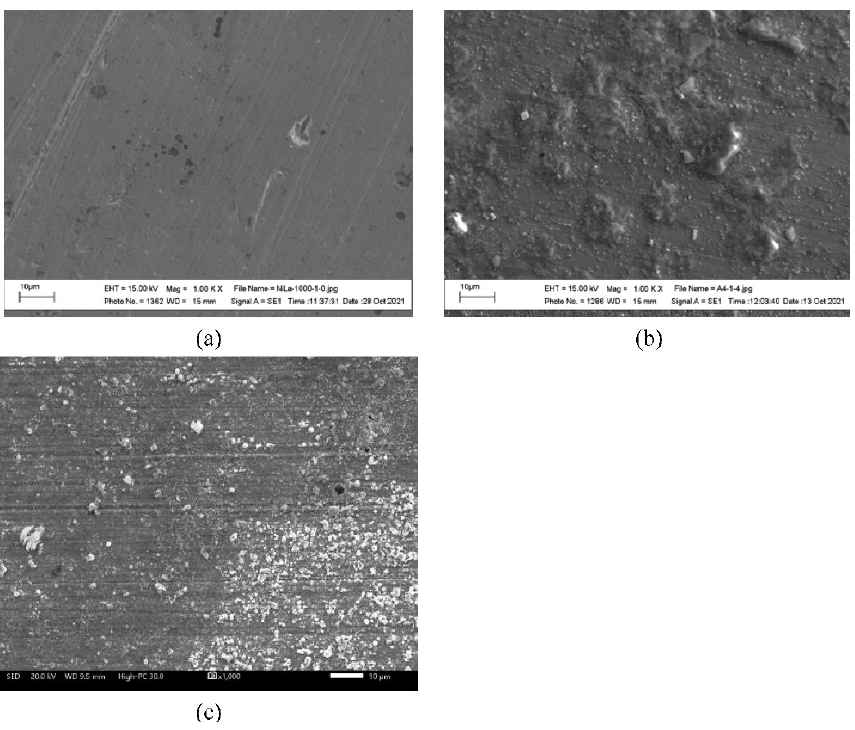
Figure 6. Morphological aspects of the Ni20Cr alloy surface immersed in the ternary salt after 1000 h and different test temperatures: ( a ) 300 °C, ( b ) 400 °C, and ( c ) 500 °C.